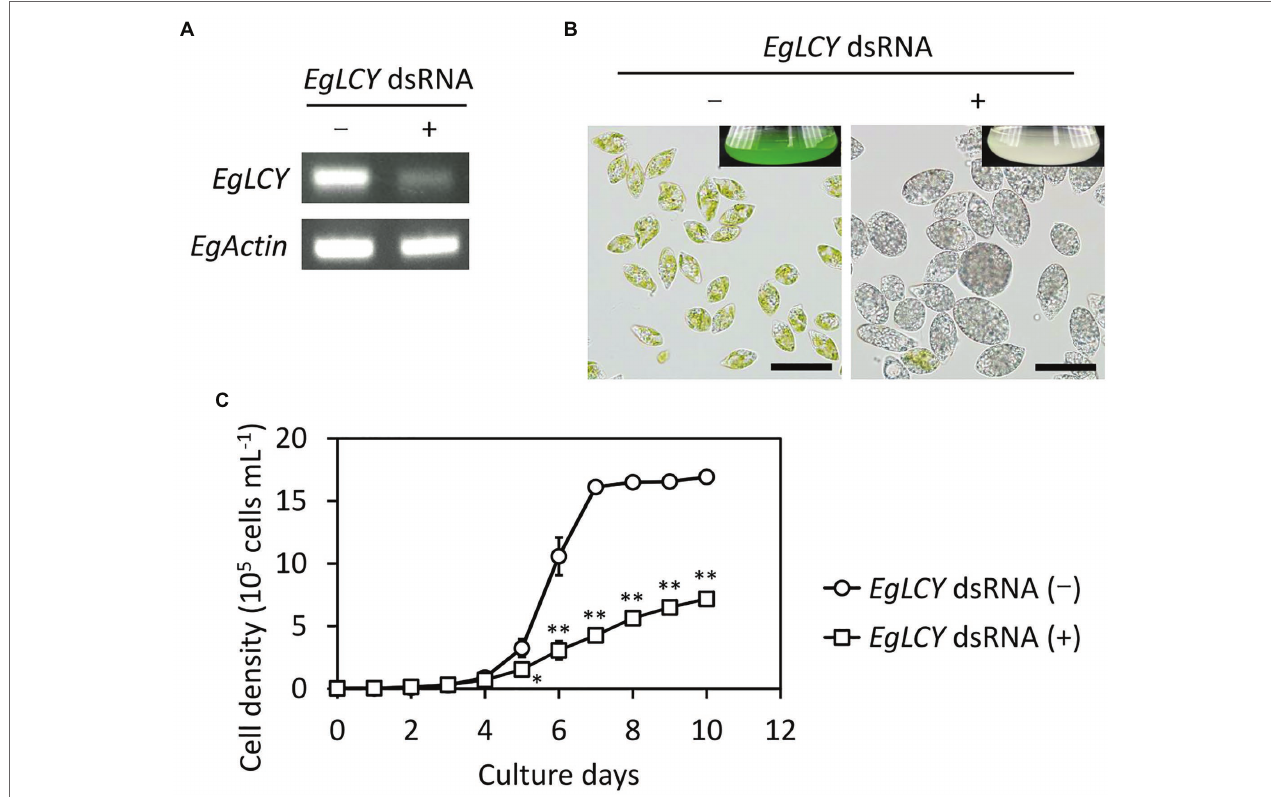
FIGURE 3 | Effects of EgLCY suppression on cell appearance and growth. Cells treated with or without EgLCY dsRNA were mixotrophically grown under continuous light (40 μ mol photons m − 2 s − 1 ) at 25 ° C. (A) EgLCY and EgActin transcript levels in cells treated with or without EgLCY dsRNA grown for 6 d. The EgActin gene was used as a constitutive control. (B) The appearances of cells and cultures (insets) of cells treated with or without EgLCY dsRNA grown for 6 d. Scale bars are 40 μ m. (C) Growth curves of cells treated with or without EgLCY dsRNA grown for 10 d. Values are presented as the mean ± SD ( n = 3). Values with asterisks are significantly different from cells treated without dsRNA according to the t -test (* p < 0.05; ** p < 0.01).